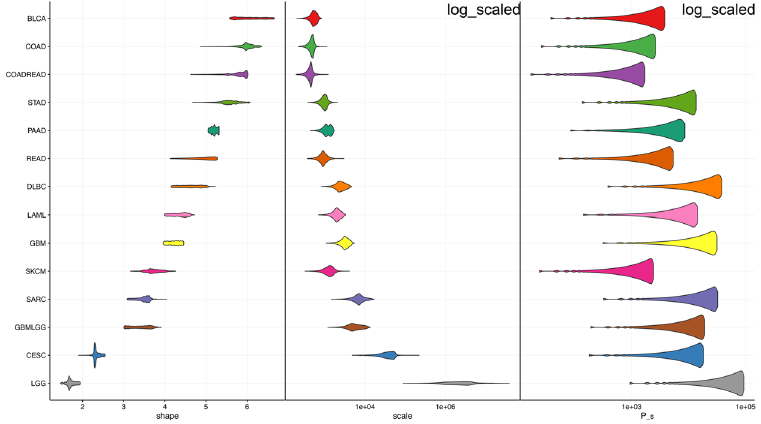
Figure 2. Sensitivity analysis of parameter estimates using the scaled Weibull function for exemplary 14 cancer types. Whereas the estimates P c for the cell population at risk and the scale parameter λ c can vary over two order of magnitude, the estimates of the shape parameter k c are within about ± 1. Notice that the shape parameter allows interpretation as the number of limiting events.